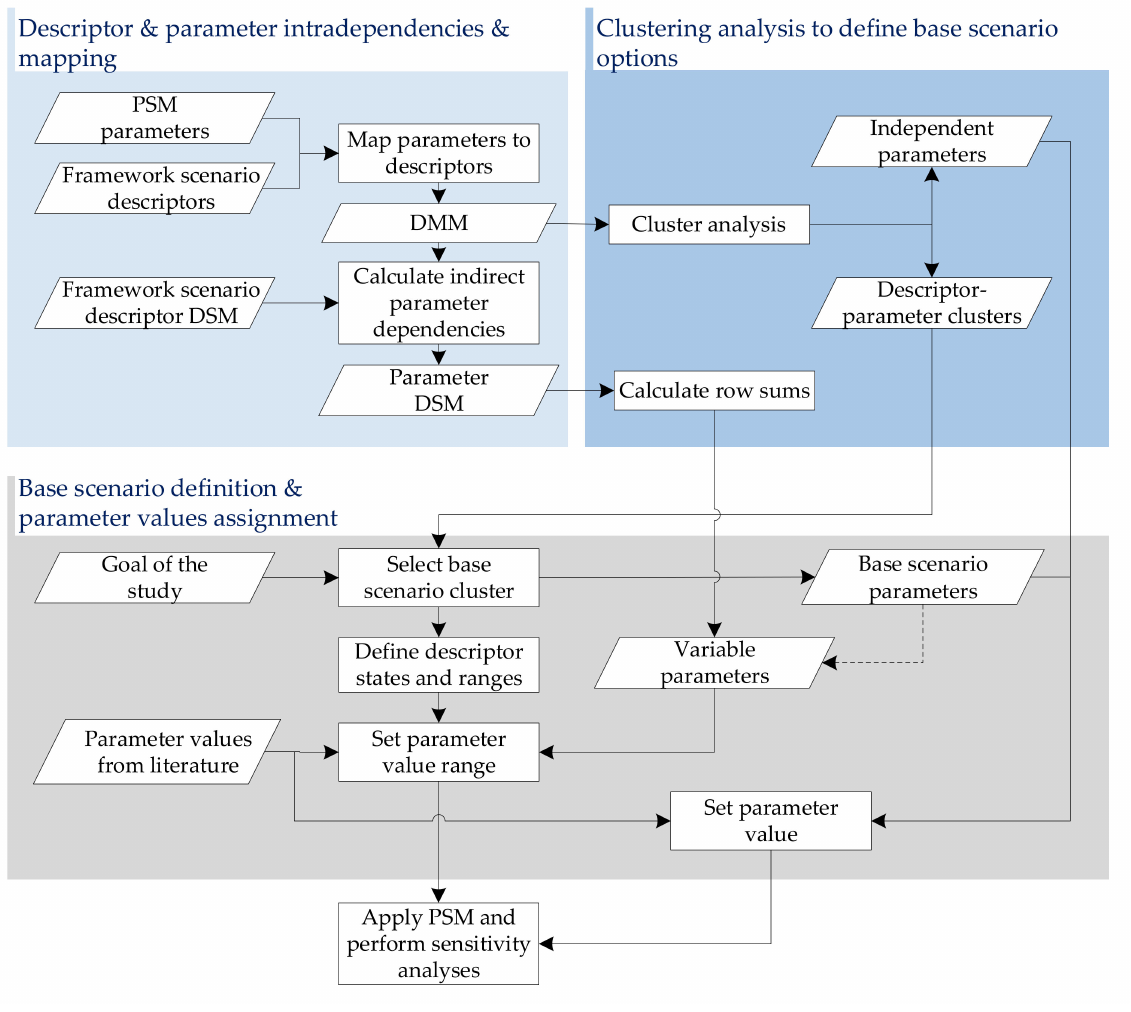
Figure 2. Socio-technical power-sector modelling: method flow chart. The method is composed of three main steps, each described in detail in the three subsequent